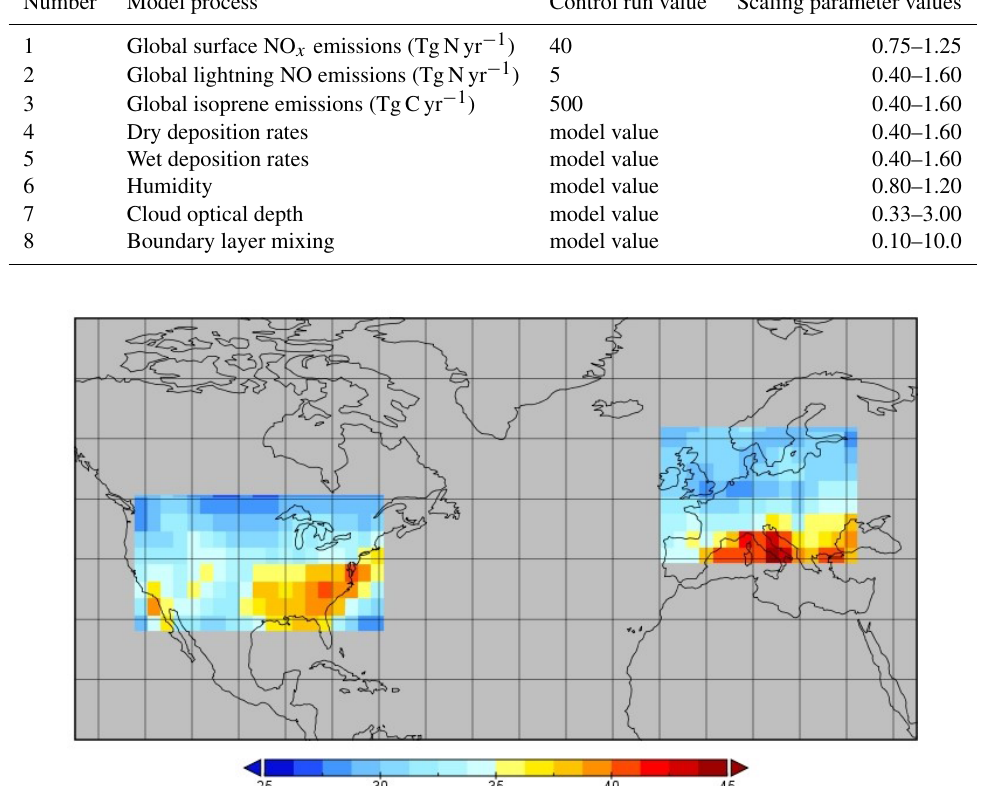
Figure 1. Annual mean surface ozone mixing ratio (in ppb) from the FRSGC/UCI CTM showing the regions considered here and the 272 grid cells used for model